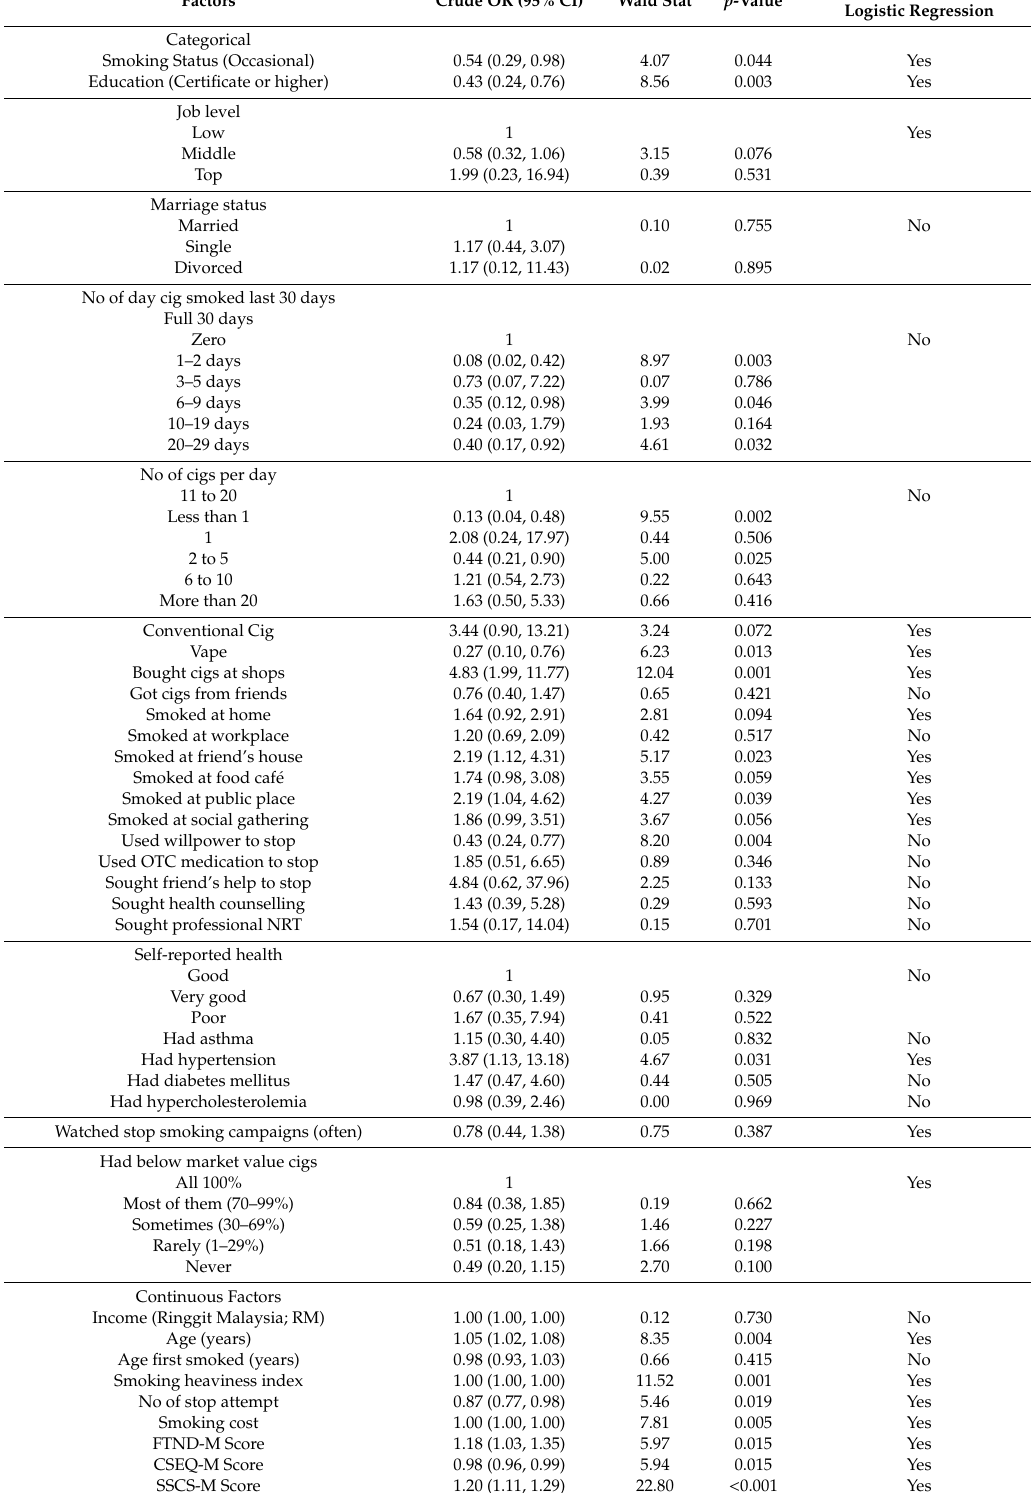
Selected for Multiple Logistic Regression